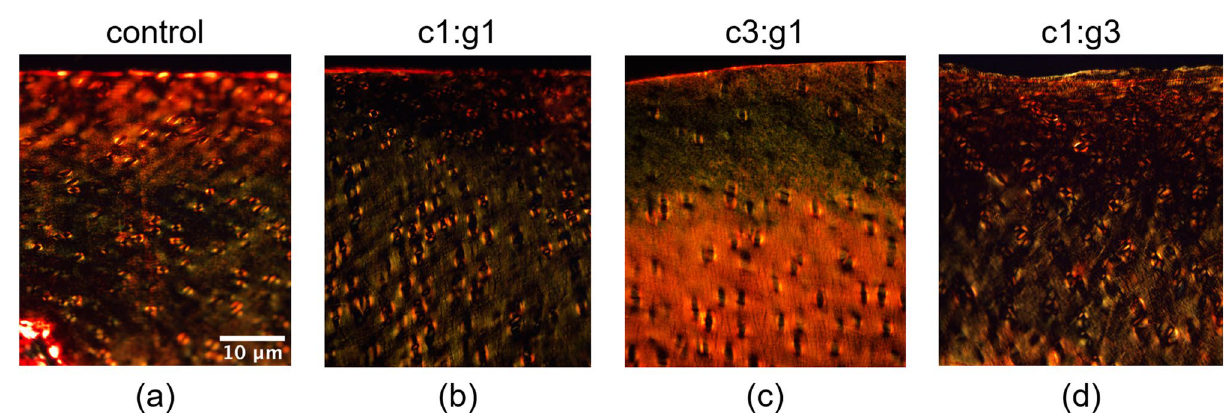
Figure 6. Collagen network visualization under polarized light microscopy of Picrosirius Red stained sections for untreated control ( a ), and MMP-1 and MMP-9 treatment groups c1:g1 ( b ), c3:g1 ( c ), and c1:g3 ( d